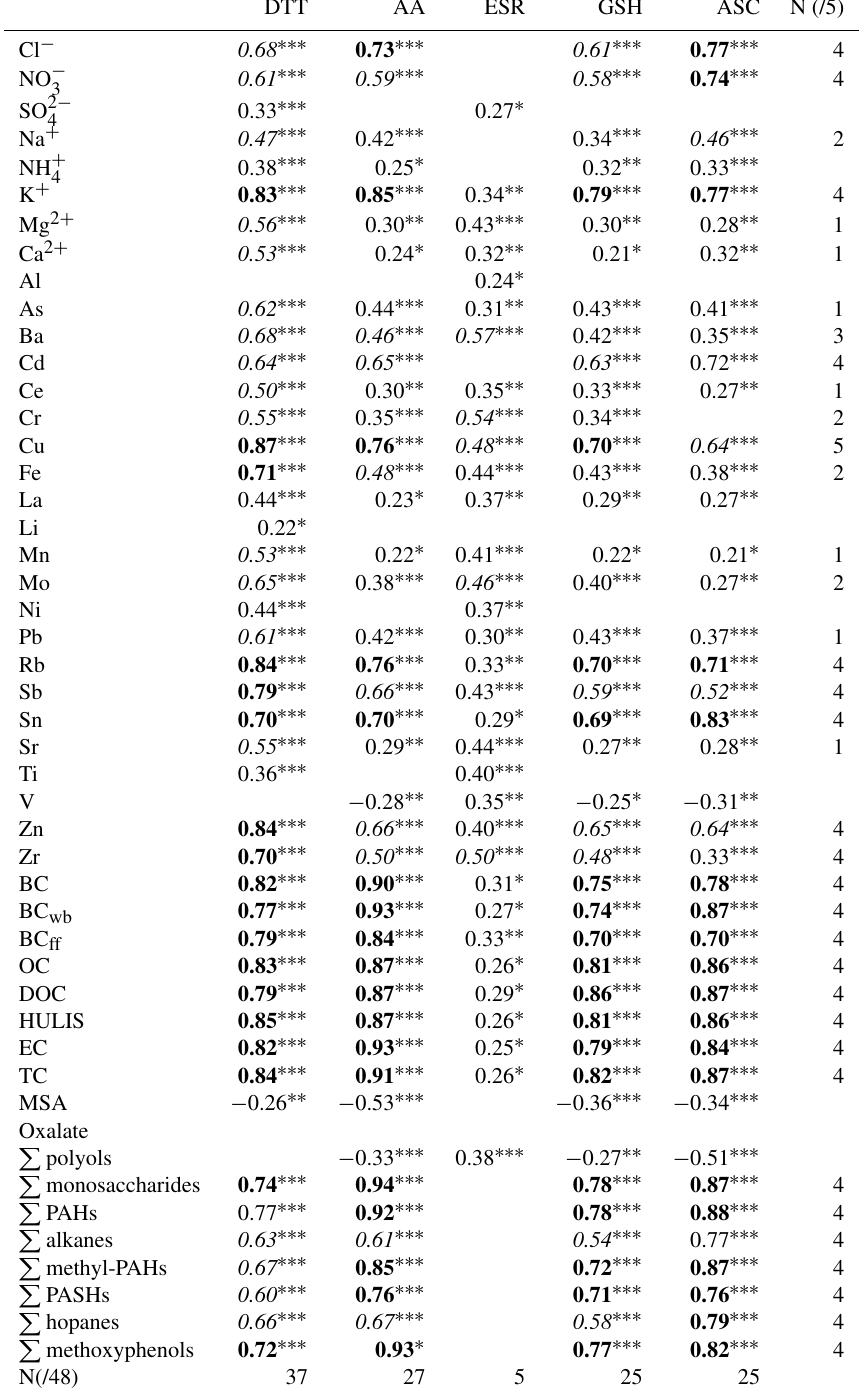
Table 4. Spearman correlations between the OPv measurement assays and the chemical composition of PM 10 (in bold: > 0 . 7, in italic: > 0 .